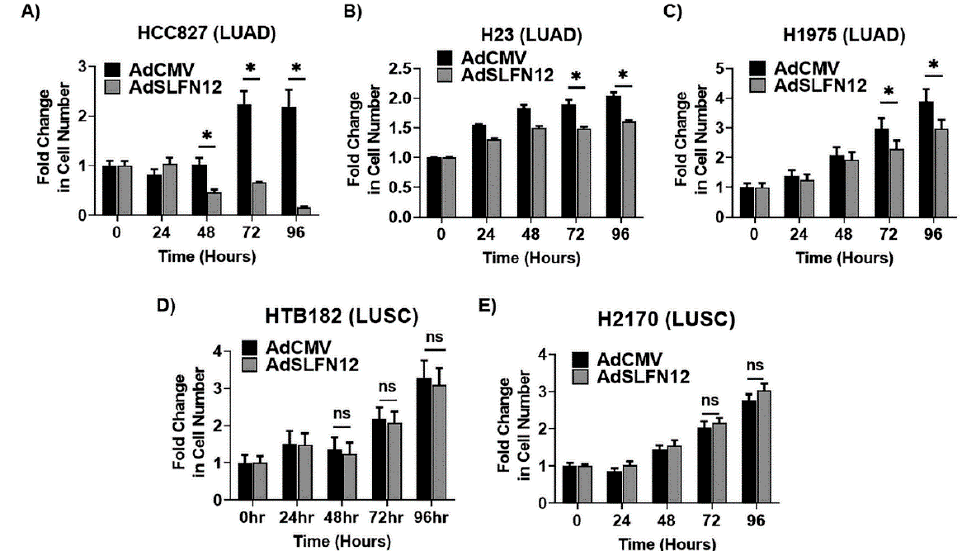
Figure 3. Schlafen 12 reduces cell number in lung adenocarcinoma cells, but not in lung squamous cell carcinoma cells. In lung adenocarcinoma, Schlafen12 overexpression using an adenoviral vector (AdSLFN12) significantly reduced cell number at 72 and 96 hours after AdSLFN12 treatment compared with the empty vector (AdCMV) treatment in the following: ( A ) HCC827, ( B ) H23, and ( C ) H1975 cells ( n = 9–12, * p < 0.05). Data represent mean fold change in cell number normalized to cell number at zero hours. In contrast, in lung squamous cell carcinoma, AdSLFN12 treatment did not reduce the cell number in ( D ) HTB-182 cells ( n = 9, ns = non-significant) or ( E ) H2170 cells ( n = 9, ns = non-significant), compared with AdCMV treatment. Data represent fold change in cell number normalized to zero hours (* p < 0.05). All data are represented as mean ± SEM.